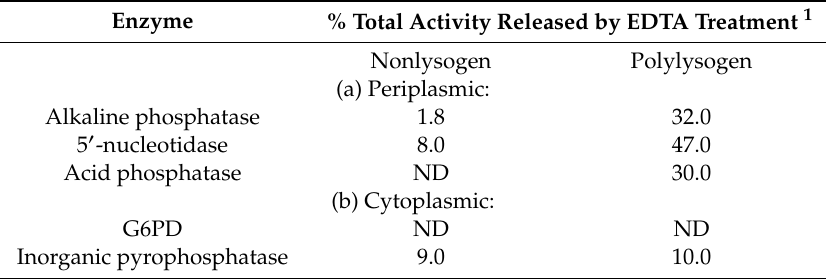
Table 2. Release of periplasmic enzymes from polylysogens by EDTA